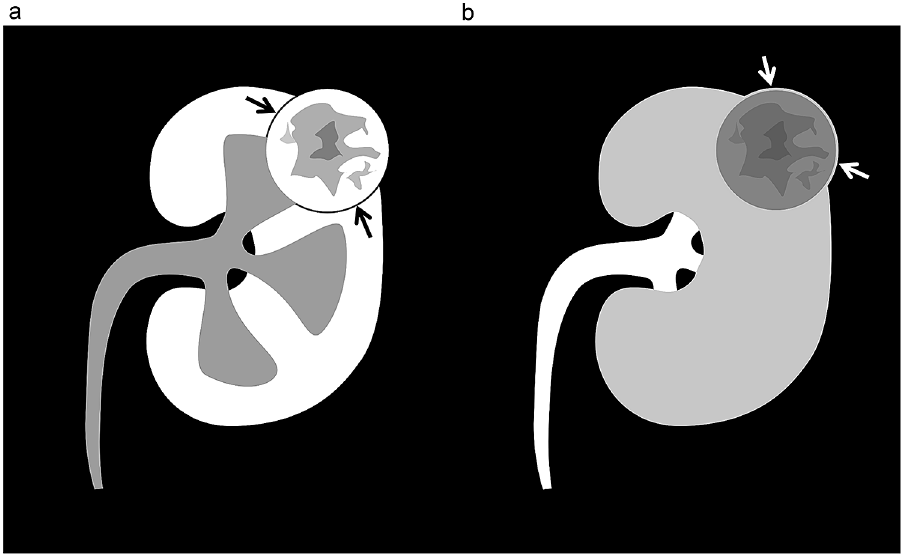
Figure 1. Schematic images of a peritumoral pseudocapsule on contrast-enhanced computed tomography images: a thin low-attenuation rim between the tumor and renal cortex (black arrows) on the cortico-medullary phase ( a ) and a higher-attenuation rim at the edge of the tumor (white arrows) on the nephrographic or excretory phase ( b